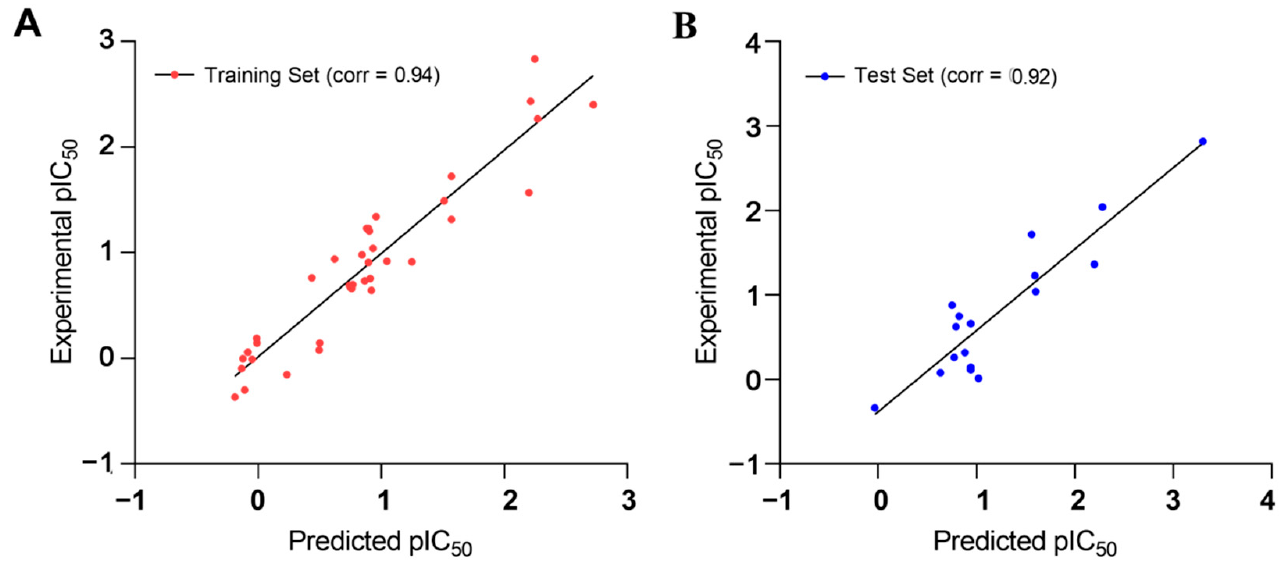
Figure 7. Observed and predicted activities of ( A ) training set and ( B ) test set compounds for the